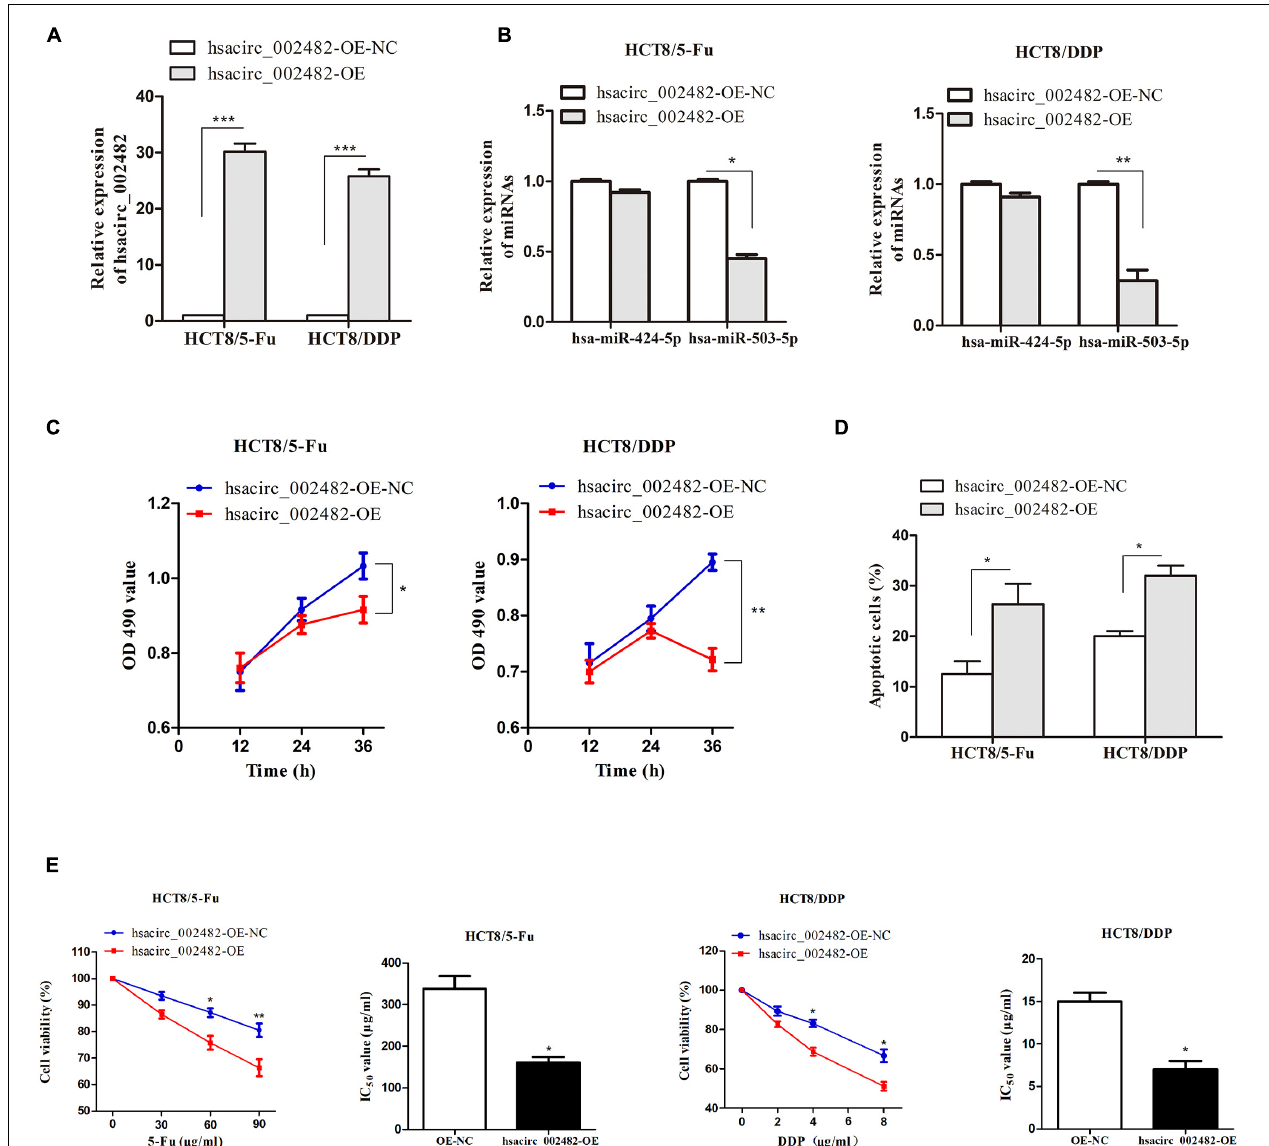
FIGURE 7 | Overexpression of hsacirc_002482 sensitizes CRC chemoresistant cells to 5-Fu and cisplatin. The expression of (A) hsacirc_002482 and (B) hsa-miR-424-5p and hsa-miR-503-5p in chemoresistant cells after hsacirc_002482 transfection. Overexpressing hsacirc_002482 (C) inhibited proliferation,